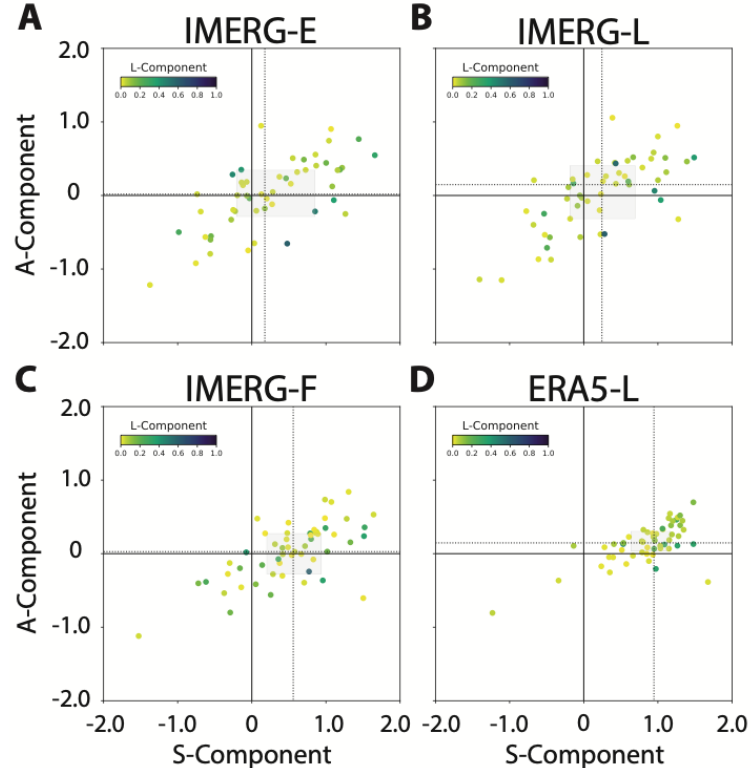
Figure 6. Structure-Amplitude-Location ( SAL) scores of 24-h accumulated precipitation for 55 cases and IMERG-E ( A ), IMERG-L ( B ), IMERG-F ( C ), and ERA5-L ( D ) datasets. Each scatter point is colored by its location component. The gray-shaded box spans the middle two quartiles (Q1–Q3) of the amplitude ( y -axis) and structure ( x -axis) components. The dotted line represents the median structure and amplitude component scores. S-A-L = 0-0-0 means a perfect score.